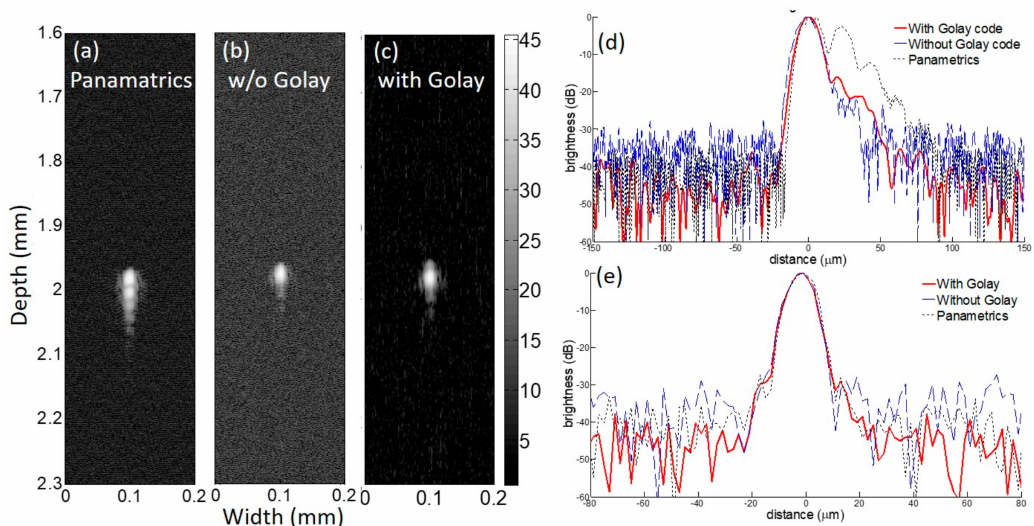
Figure 5. Wire target study results at 156 MHz imaging frequency: B-mode images are acquired with ( a ) Panamatrics pulser/receiver; ( b ) proposed analogue frontend without coded excitation; and ( c ) with coded excitation. The brightness profiles in dB scale represents ( d ) axial profile and ( e ) lateral profile. Note that the red solid, blue dashed, and black dotted lines represent the profiles with Golay, without Golay, and Panametrics pulser/receiver, respectively. Note that the scale of the gray bar is decibel (dB). In Figure 6, the results from two types of transmit waveforms; a bipolar single pulse from the implemented pulser/receiver and 4-bit pseudo unipolar Golay coded excitation are compared. The − 6 dB axial resolution values for the bipolar and the Golay transmissions are 4.4 µ m and 4.9 µ m, respectively and the lateral resolution values are 7.6 µ m and 7.2 µ m, respectively. The SNR for the single cycle and Golay transmission are 20 dB and 29 dB, respectively.